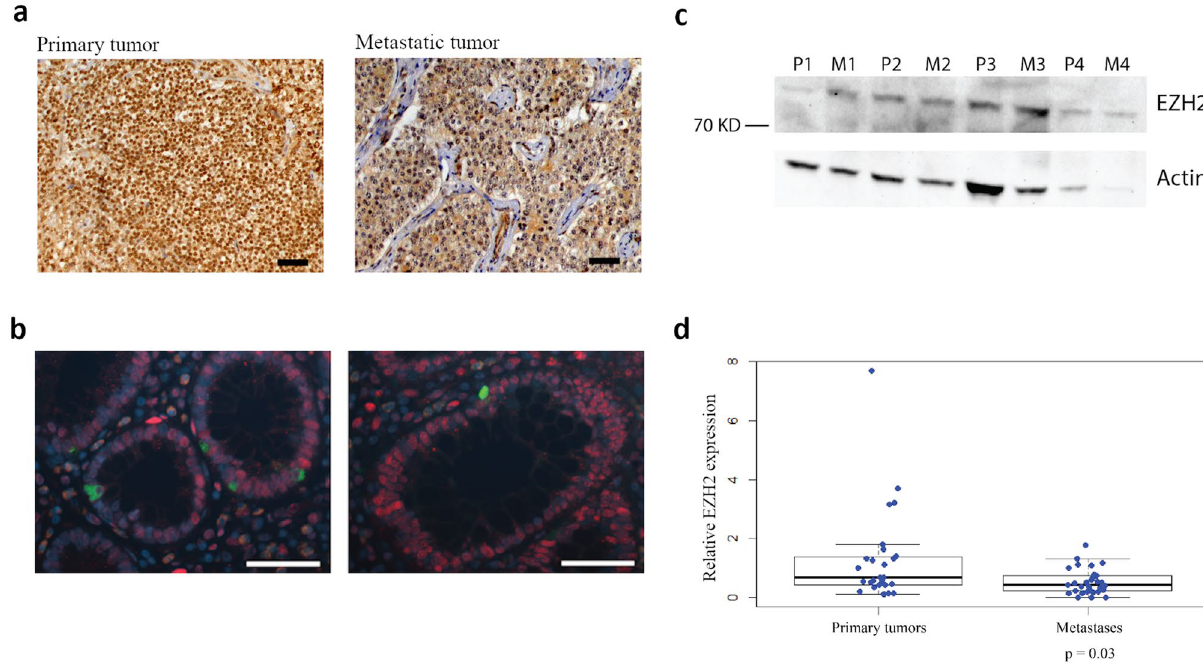
Figure 1. EZH2 expression in SI-NETs. ( a ) Representative results from immunohistochemical analysis of EZH2 in 17 PTs and 21 paired MTs; positive staining regardless of strength in a primary and a metastatic tumor. Scale bar 50 µm. ( b ) Immunofluorescent double staining for chromogranin A and EZH2. Chromogranin A-positive cells (green) are negatively stained for EZH2 (red) in normal small intestinal tissue. Scale bar 50 µm. ( c ) Western blot analysis of EZH2 in 4 PTs and paired MTs (n = 8). Actin was detected on the same membrane as loading control, and full-length blots are presented in Supplementary Figure S1. ( d ) mRNA expression level of EZH2 in PTs (n = 27) and paired MTs (n = 33). Wilcoxon–Mann–Whitney U test result displayed in the boxplot ( p =